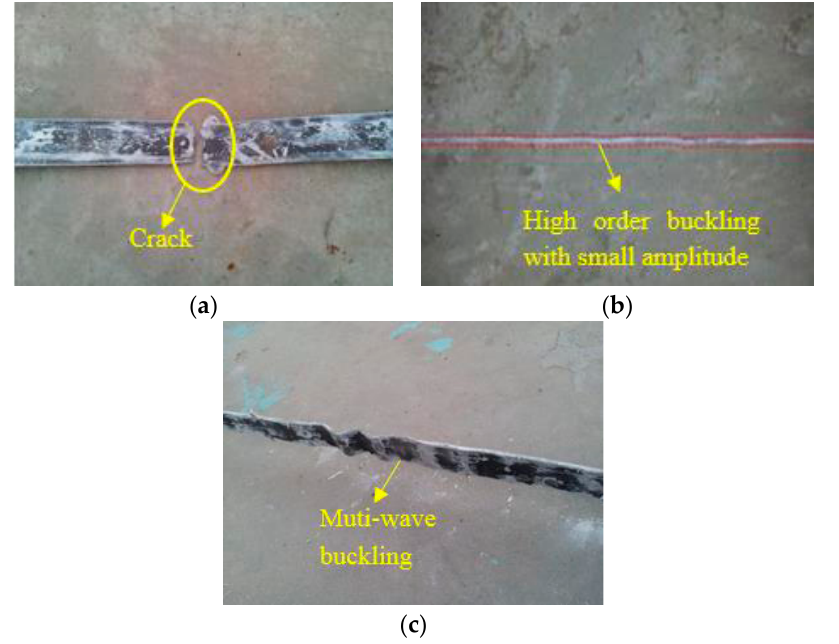
Figure 9. Buckling modal of the inner core: ( a ) damage form of S1’s inner core element, ( b ) buckling modal of S3’s inner core element; and ( c ) buckling modal of S4’s inner core element.